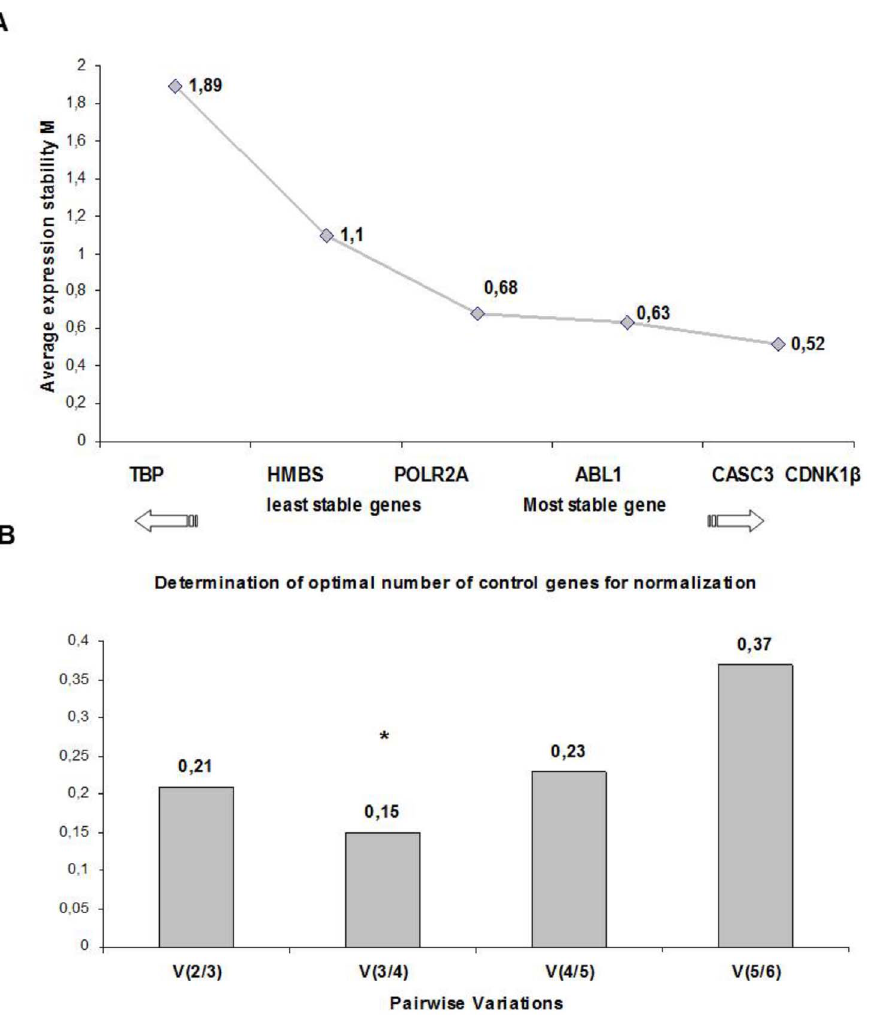
Figure 2. Stability values (A) and pair-wise variation values (B) of reference genes obtained by GeNorm. A pair wise variation value of 0.15 was obtained for V 3/4 (B), indicating that three genes are required for normalization according to GeNorm. The three most stable reference genes suggested by GeNorm were CDKN1 b , CASC3, and ABL1 (A). Note that POLR2A also shows a low M stability value (0.68), similar to that of ABL1 (0.63).